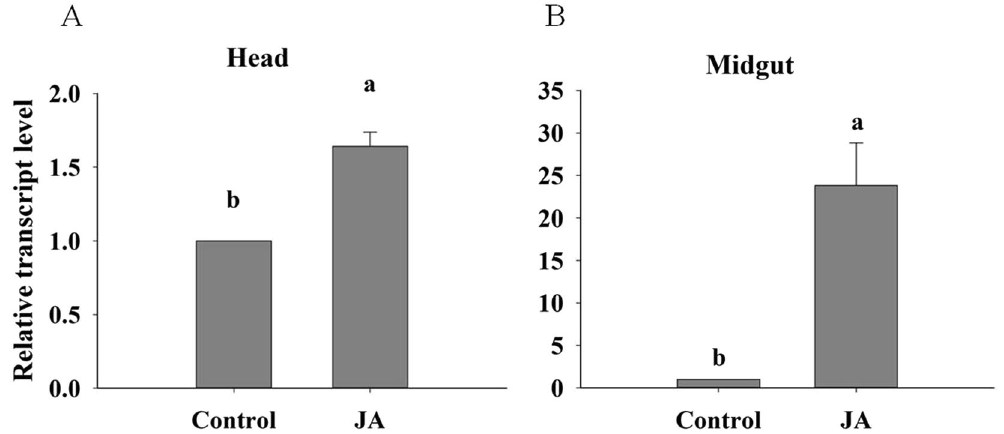
Figure 4. Transcript levels of LAC1 in JA-sprayed plant-fed or control plant-fed B. tabaci . ( A ) Expression in heads (containing the salivary glands). ( B ) Expression in the midgut. Values are represented as the mean ± SEM. The letters above the columns indicate the comparison among groups, p <